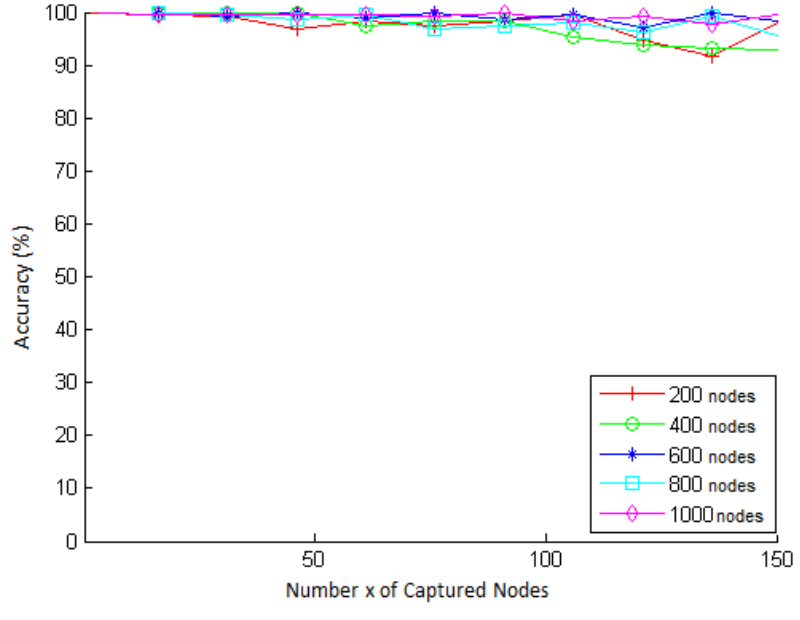
Figure 5. Accuracy of the key management resilience probability ( P captured nodes, for different network sizes, k = 200 keys, p = 0 . 33 and q = 3